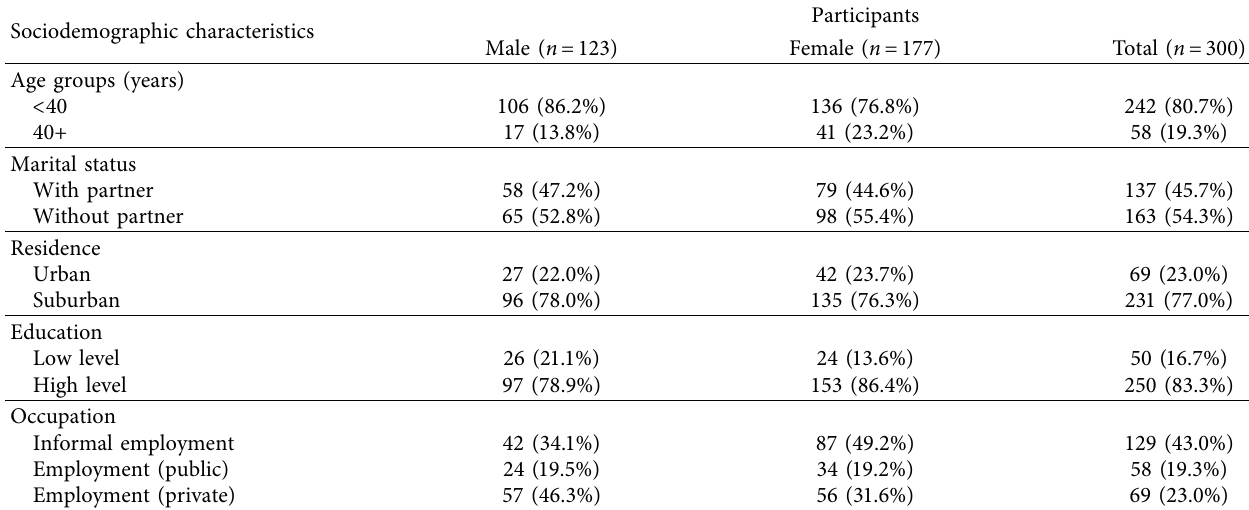
Table 1: Distribution of study participants according to sociodemographic characteristics.